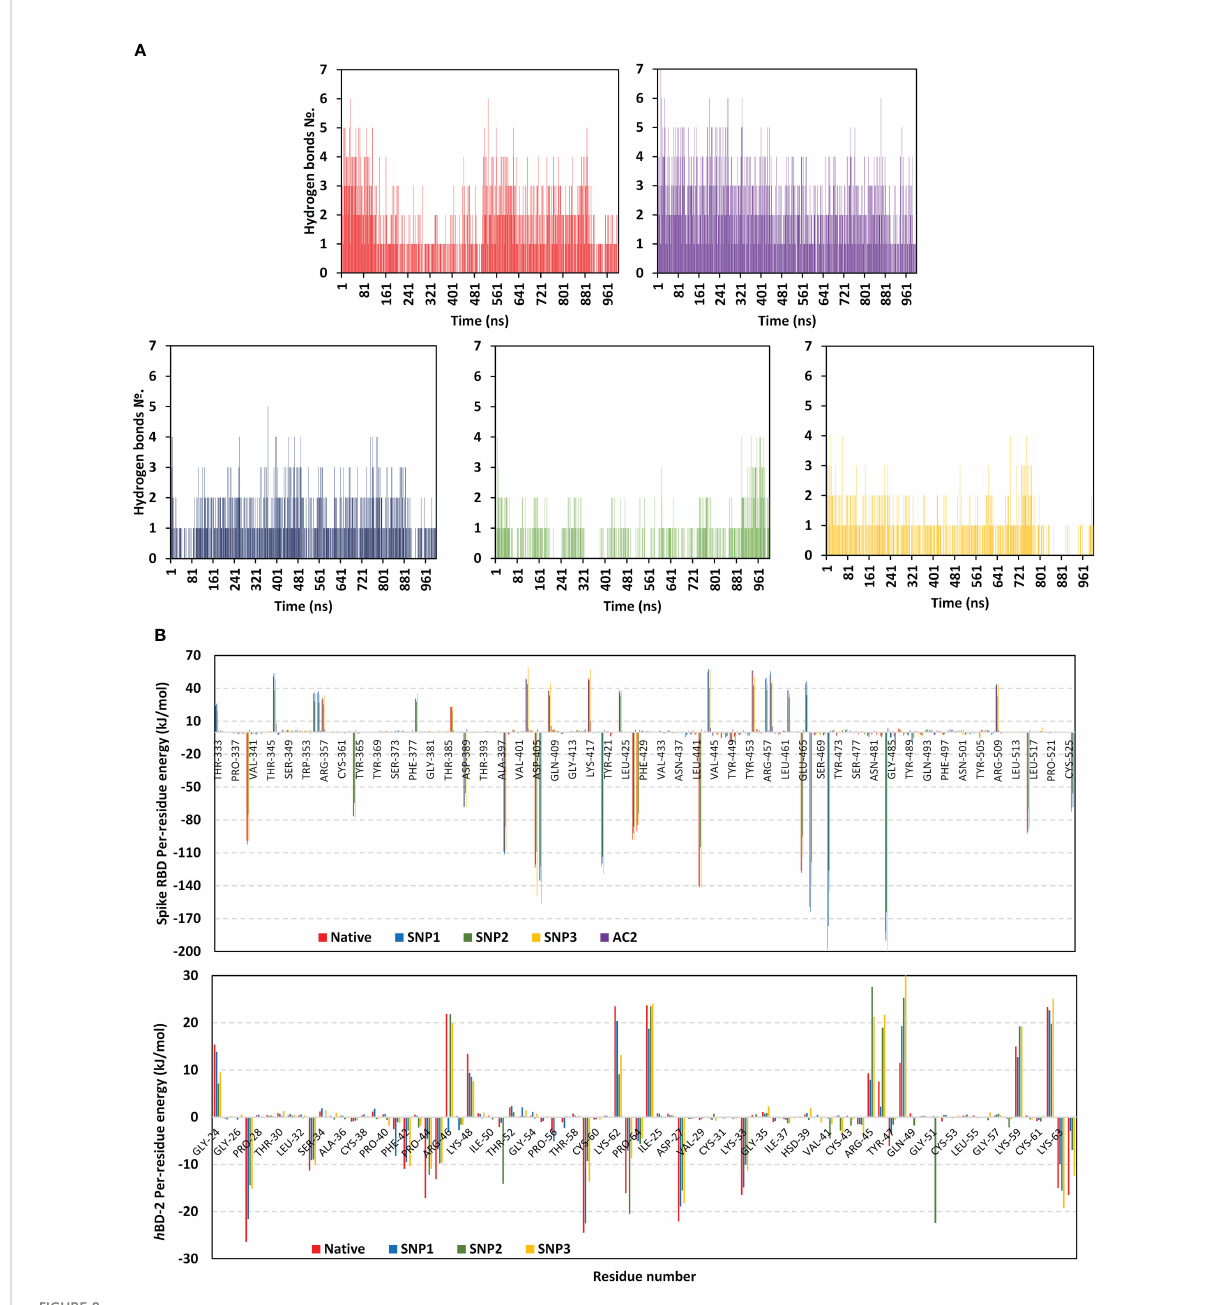
FIGURE 8 Binding interaction analysis for the simulated spike RBD/ligand complexes across the molecular dynamics simulations. (A) Number of furnished hydrogen bonds by the simulated complexes of native h BD-2, h ACE2, SNP1, SNP2, and SNP3 ligands (upper left, upper right, bottom left-to- right panels, respectively), as a function of the simulated times (ns). (B) Per-residue MM-PBSA free binding energy contributions for spike RBD and ligand